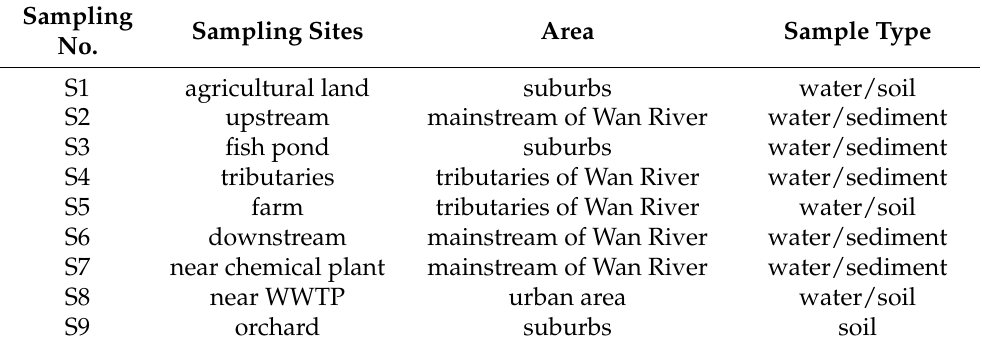
Table 1. Detailed information of sampling sites in Anqing